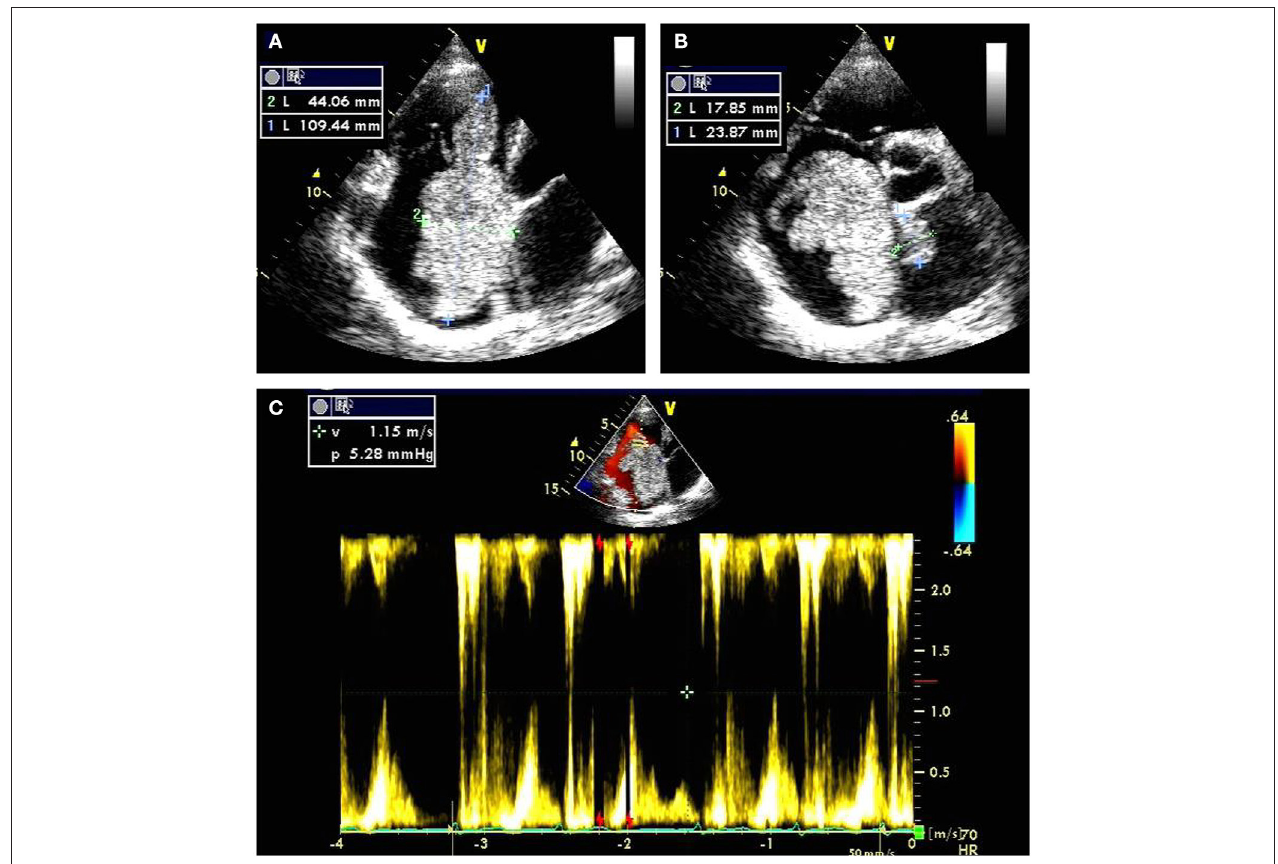
FIGURE 1 | Transthoracic echocardiography preoperatively showing a giant biatrial mass with the size of 44.06mm × 109.44mm in the right atrium (A) and 17.85mm × 23.87mm in the left atrium (B) ; Color Doppler flow imaging showing severe mechanical hemodynamic obstacles in the right atrium primarily occupied by the giant tumor tissue (C)